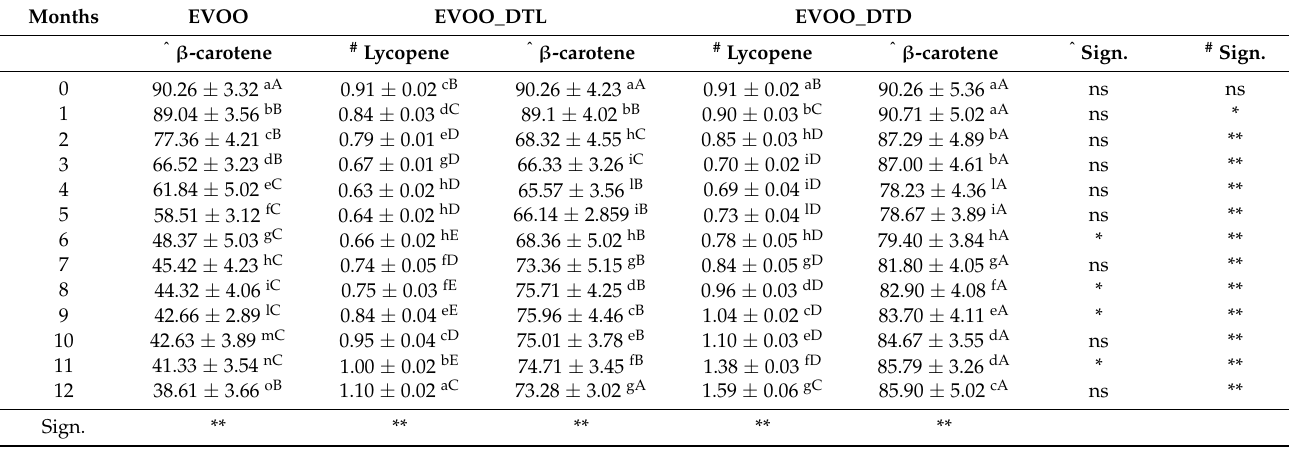
Table 3. β -Carotene and lycopene content in EVOO, EVOO_DTL, and EVOO_DTD samples (mg/100 g).